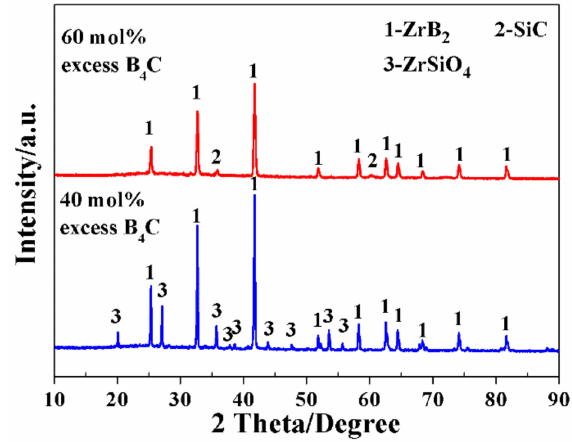
Figure 9. XRD patterns of the samples prepared at 1200 ◦ C/20 min with 40 mol % and 60 mol % excess B 4 C in raw